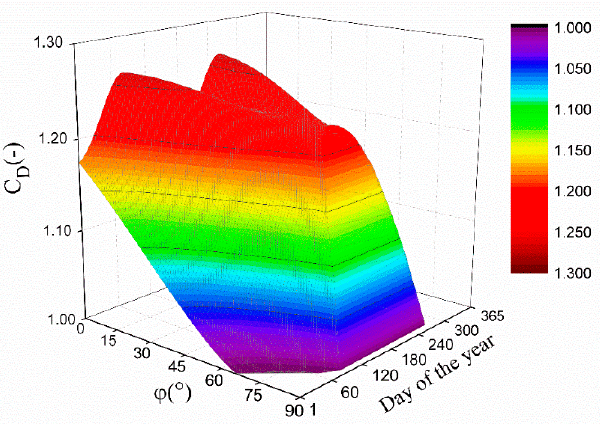
Figure 21. Surface chart of C D varying with day of the year and different latitudes at β = 0.